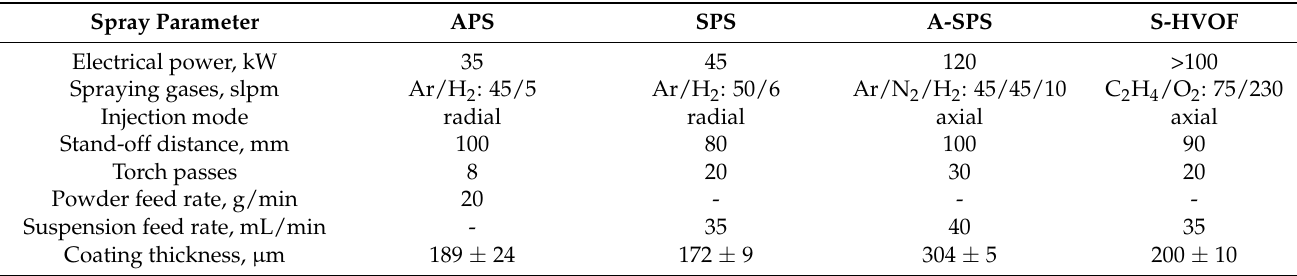
Table 2. Main spraying parameters. For each process, the most appropriate spraying conditions were chosen to produce alumina coatings that were as dense as